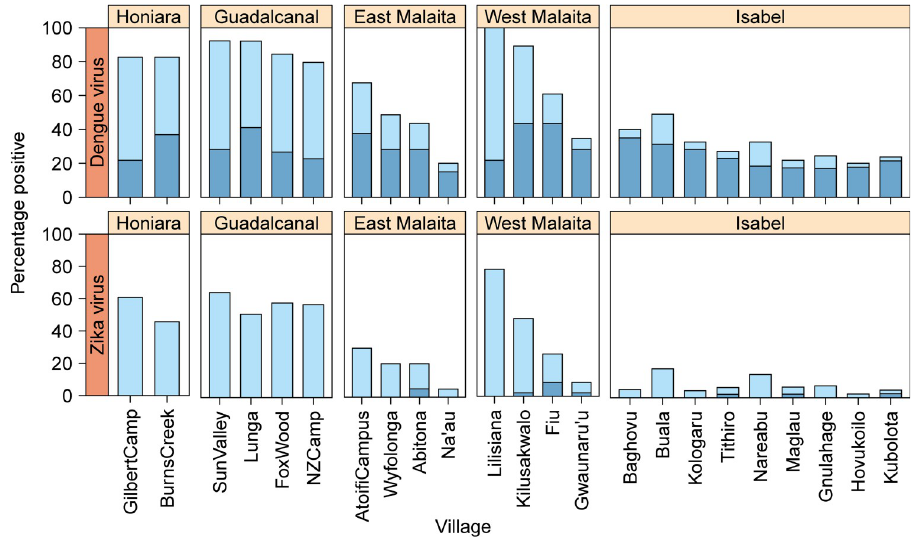
Fig 2. The seroprevalence of flaviviruses across sub-areas in the Solomon Islands. The darker blue colour represents samples that were flavivirus-positive for dengue or Zika alone. The lighter blue colour represents samples that were positive for both dengue and Zika.